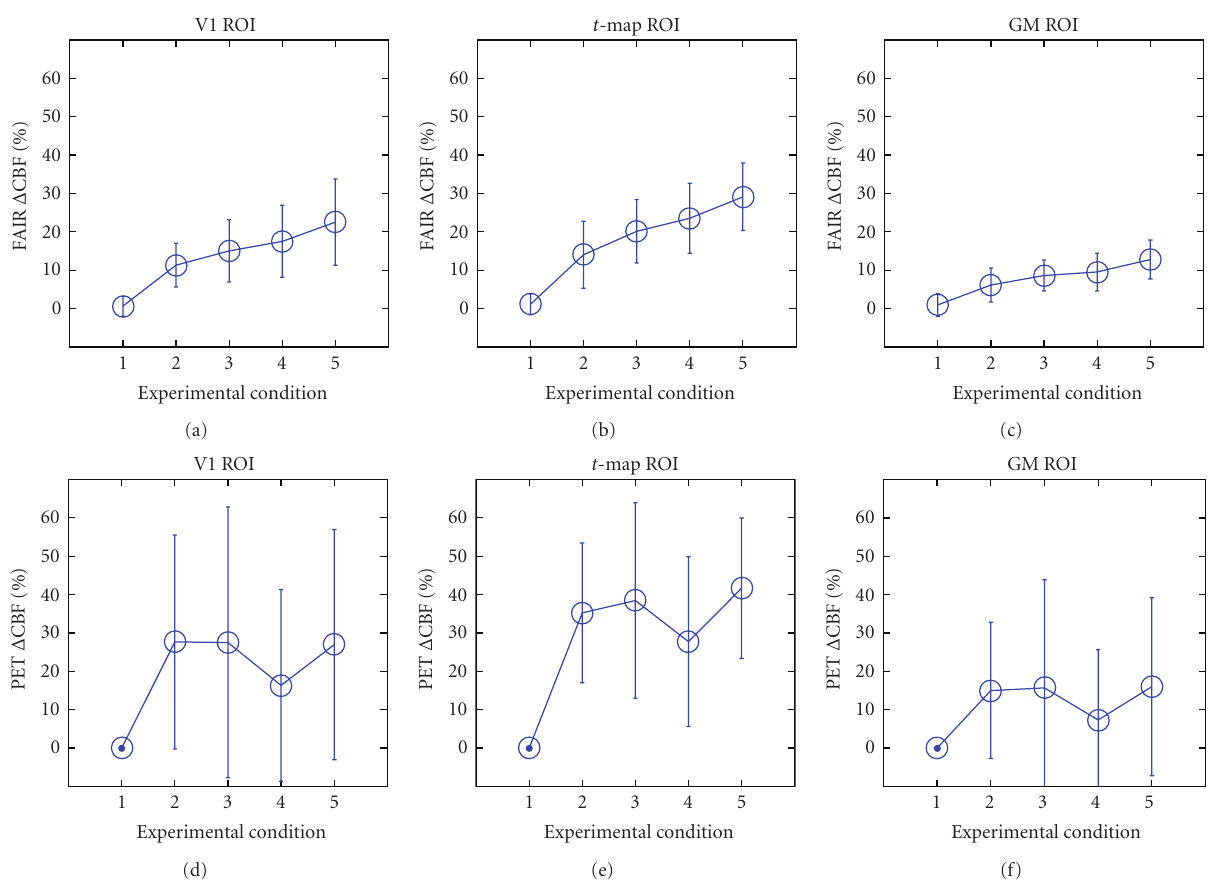
Figure 5: FMRI (top) and PET (bottom) CBF percent changes during visual stimulation in the V1, t -map, and GM ROIs. Error bars represent the standard deviation in the data. Experimental conditions 1 to 5: baseline, 25%, 50%, 75%, and 100% intensity checkerboard visual stimulation. The FAIR CBF maps have considerably higher SNRs than PET maps, and there was a consistent monotonic increase in the CBF percent change ( Δ CBF) with stimulus intensity in the FAIR data which could not be discerned distinctively in PET given the limited